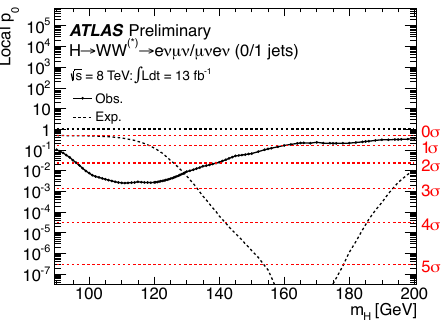
Figure 3. Observed probability for the background-only scenario as a function of m H [5]. The dashed line shows the corresponding expectation for the signal + background hypothesis at the given value of m H .